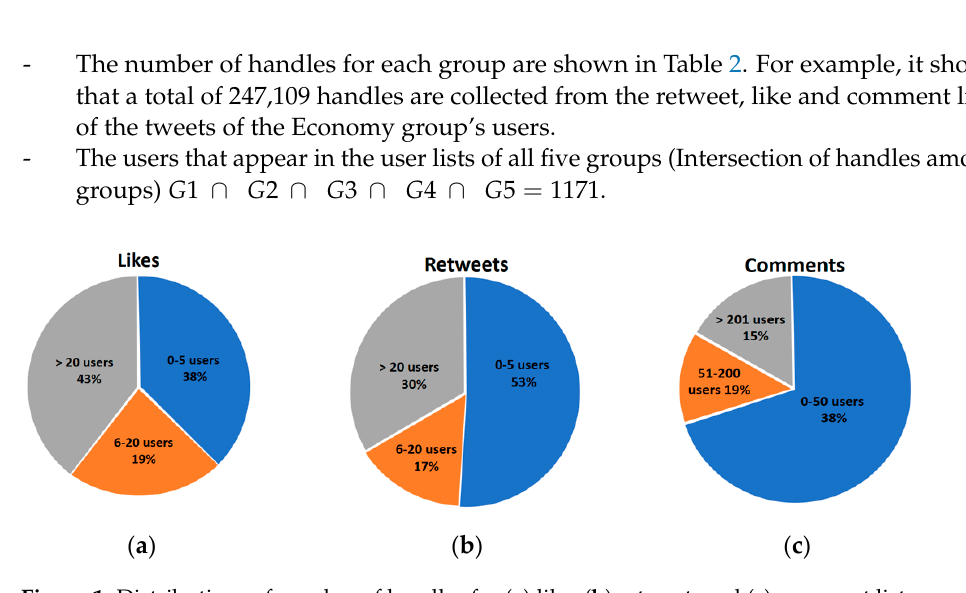
Figure 1. Distributions of number of handles for ( a ) like, ( b ) retweet, and ( c ) comment lists. Table 2. Group descriptions and number of interactions. Group Id